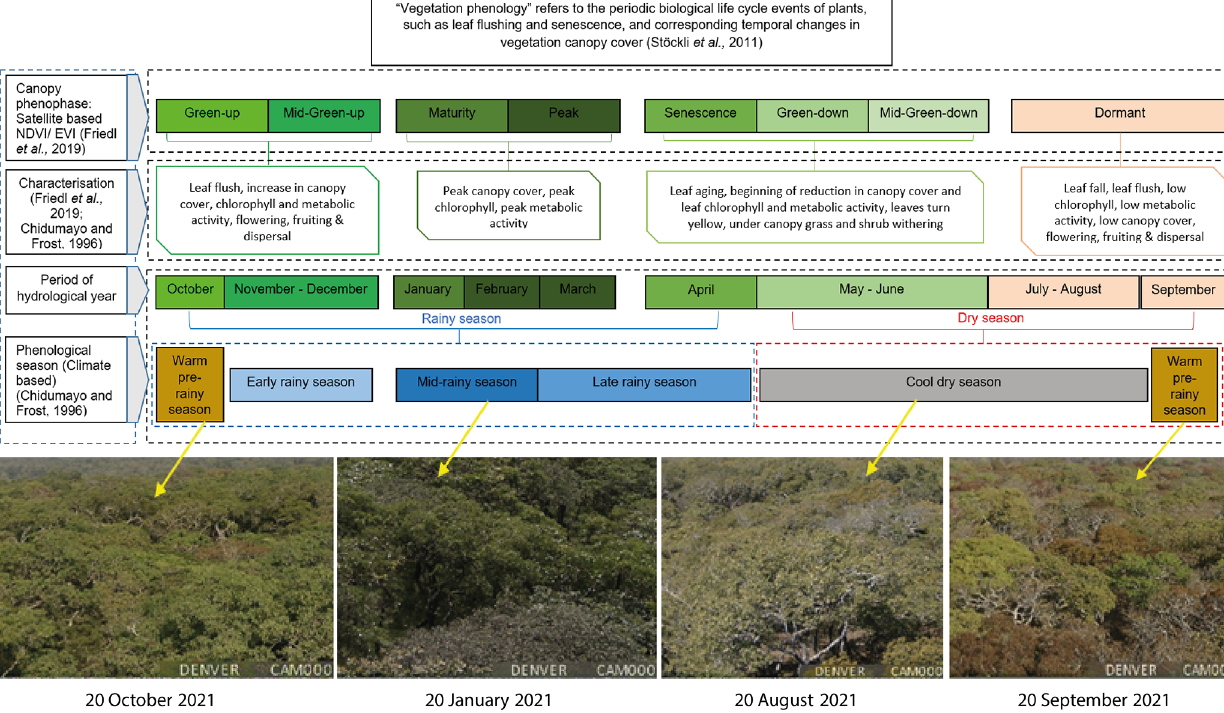
Figure 2. Characterisation of canopy phenophases of the miombo woodland in relation to seasonality at the study site. Photographs show the changes in the canopy cover on selected days across phenophases for the year